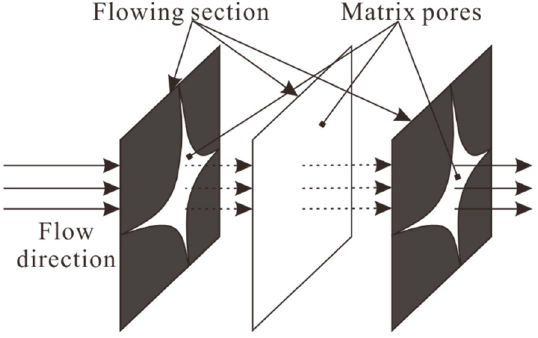
Figure 4. Fluid flow through the pore section diagram.